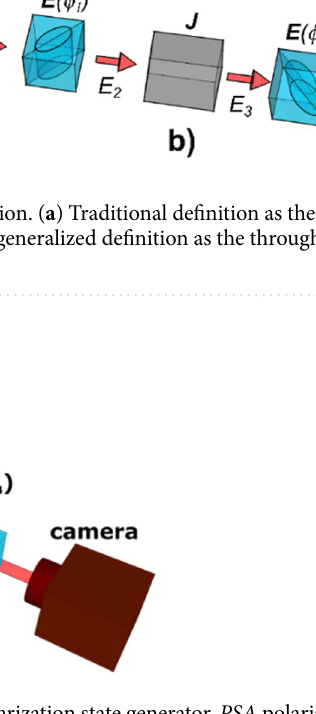
Figure 2. Mueller matrix polarimeter. PSG polarization state generator, PSA polarization state analyzer; P 1 , P 2 —polarizers; H 1 , H 2 —half-waveplates; Q 1 , Q 2 —quarter-waveplates. The angles φ denotes the inclination of the waveplates fast axes from the vertical